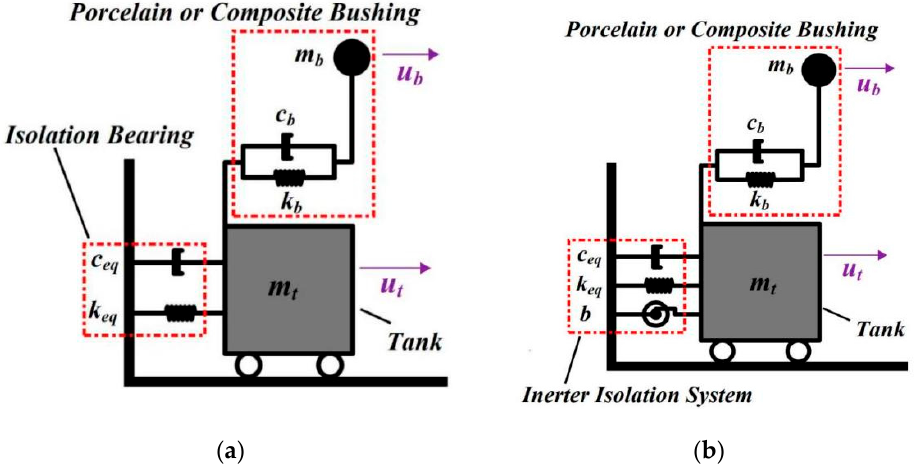
Figure 3. Mechanical model of transformer–bushing system: ( a ) IB; ( b ) IIS.2.3. Motion Control Equation of Transformer–Bushing System with